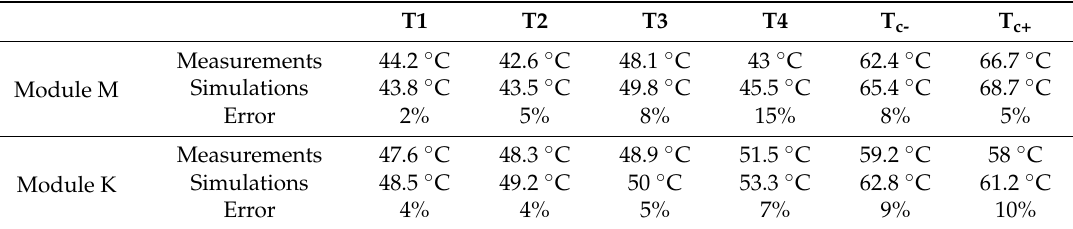
Figure 9. Temperature measurement on the global system—module K. Table 5. Power dissipation P J in the different elements— I eff = 150 A– T a = 26.5 ◦ C—The error calculation is made using T a as reference temperature. The error is defined by: (maximum value—minimum value)/(minimum value—ambient